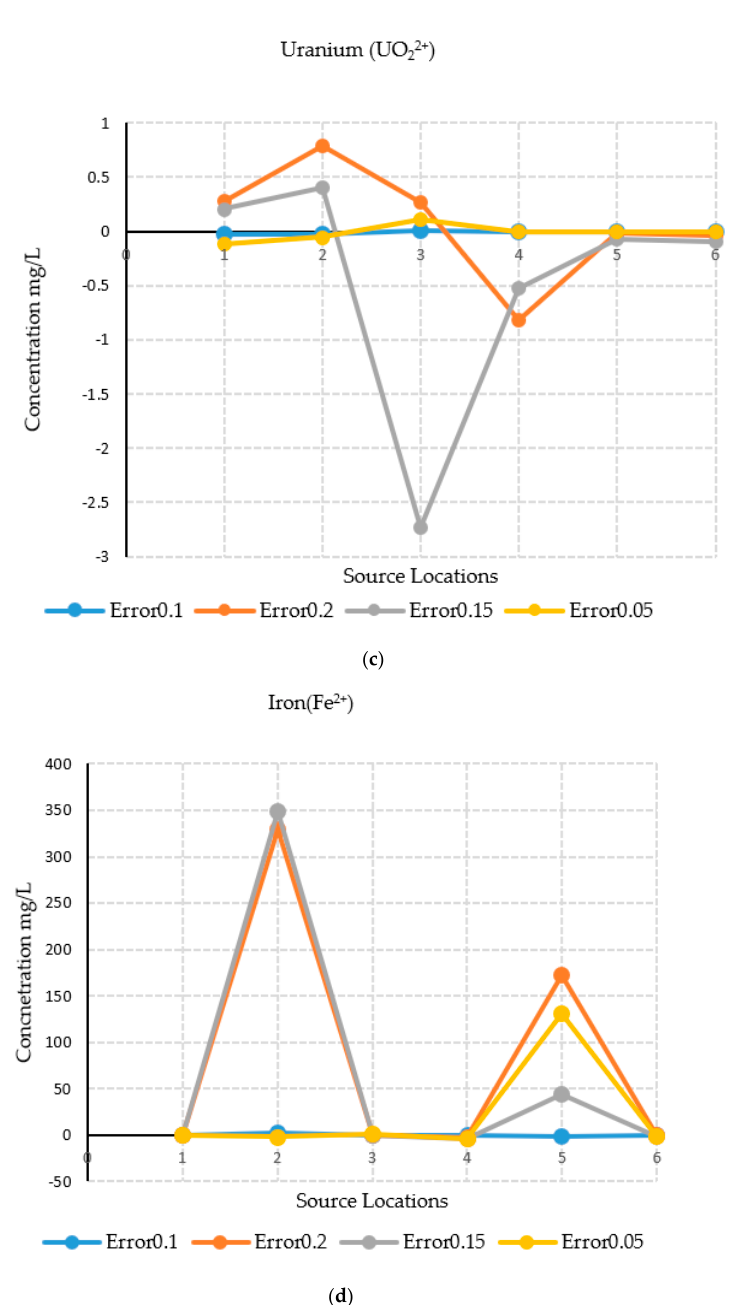
Figure 14. Comparison of the source identification errors obtained using different erroneous measurement data: ( a ) Cu 2+ species; ( b ) SO 42- species; ( c ) UO 22+ species; ( d ) Fe 2+ species.